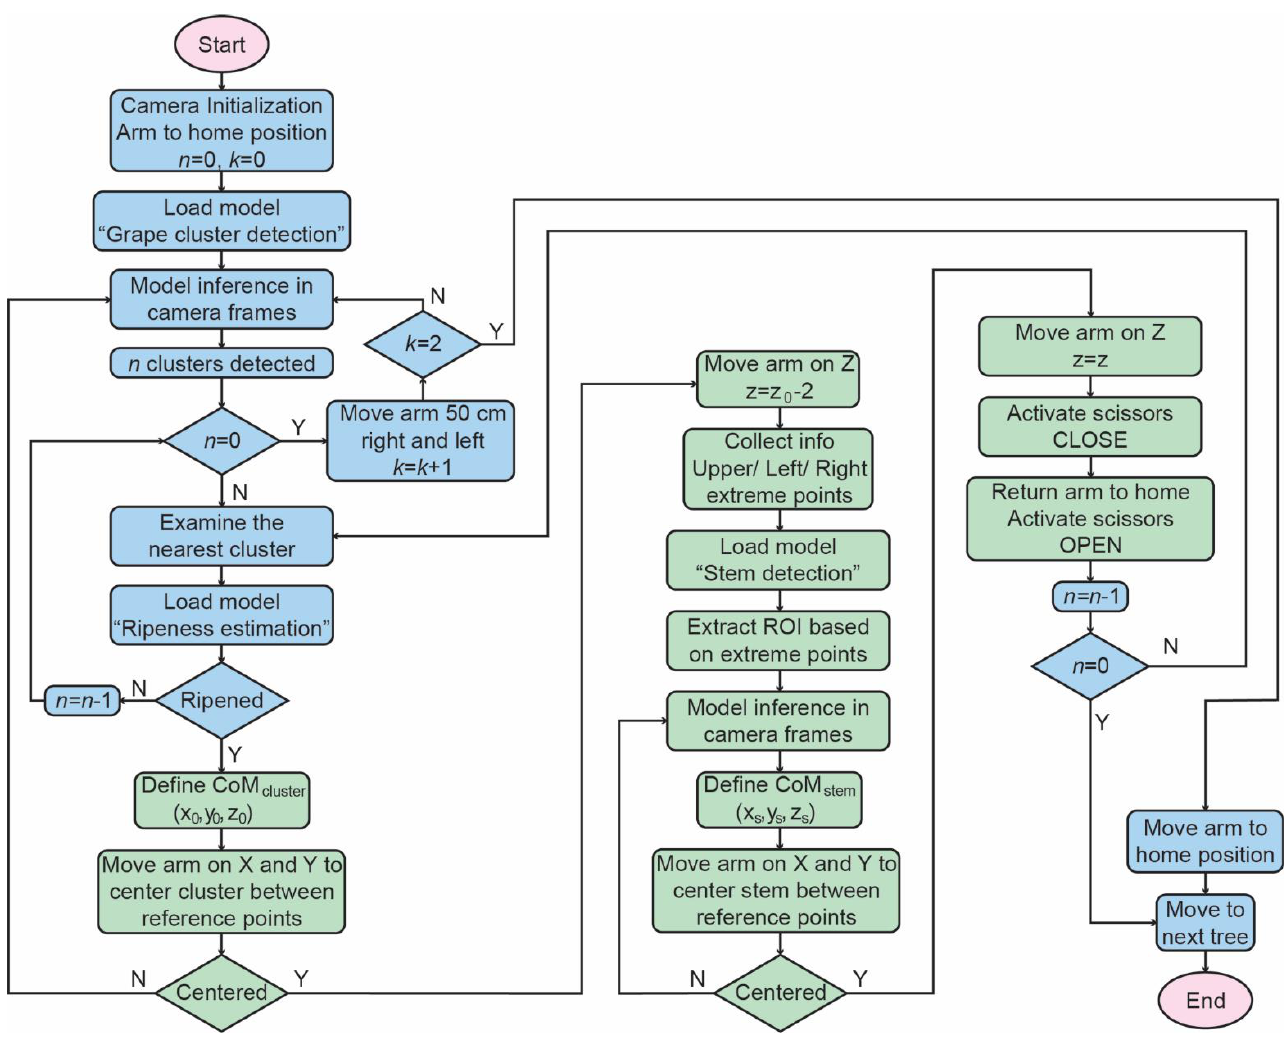
Figure 3. Workflow of the harvesting task. The workflow of the green harvesting task is illustrated in Figure 4. For green harvest and defoliation, vine trunks are used as visual landmarks for navigation. The ARG performs all tasks after stopping in parallel with the vine trunks. All removed leaves or clusters in those tasks are left to fall on the ground and outside any